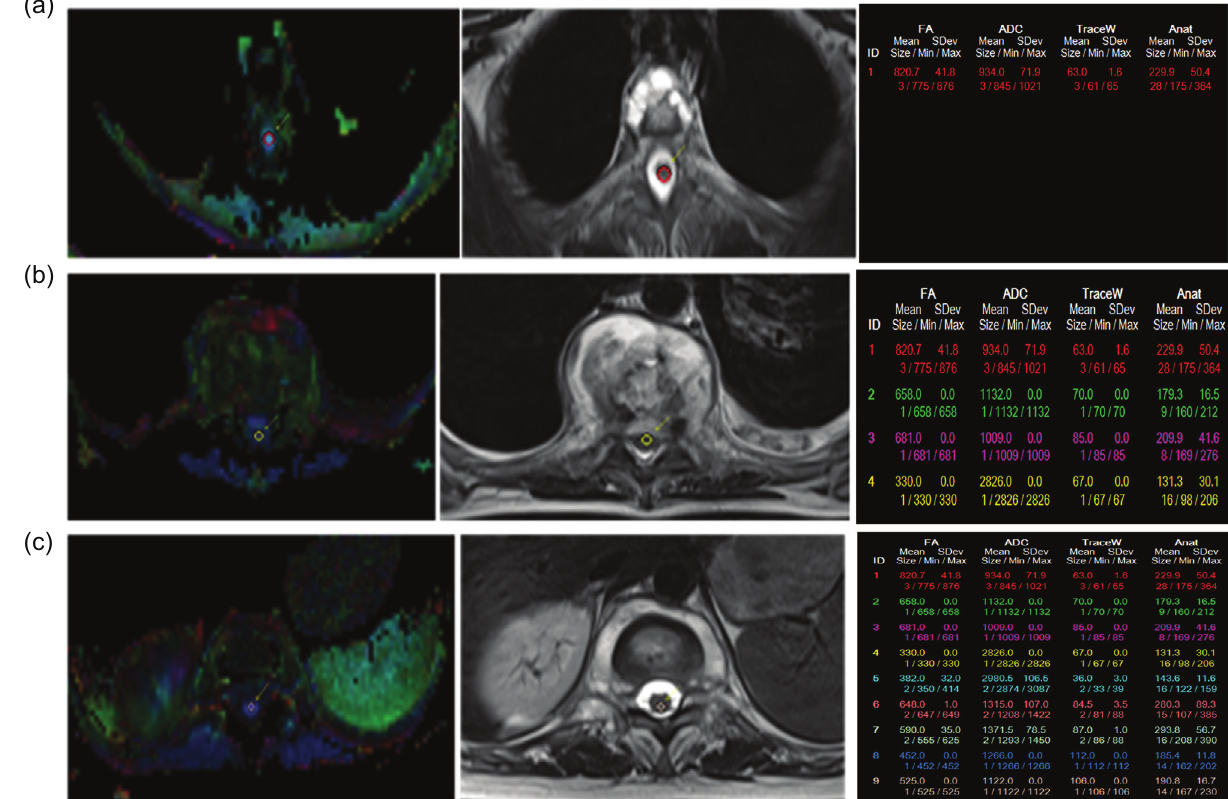
Figure 2. (a) Left: circular ROI drawn for calculation of FA and MD/ADC values on diffusion FA map above the site of lesion (SOL). Middle: corresponding T2 axial MRI image shows no disease above the SOL. Right: once circular ROIs were drawn, FA and MD values were generated which were recorded. Three such ROIs were drawn above the SOL. (b) Left: circular ROI drawn at the SOL. Middle: corresponding axial MRI image shows disease and compression on cord. Right: FA and MD values generated in the same color as ROI. Note: The first three values are for above the SOL. (c) Left: circular ROI drawn below the SOL. Middle: the corresponding axial MRI image shows no disease. Right: FA and MD values generated. Values (1–3) – above SOL (4–6) – at SOL (7–9) – below